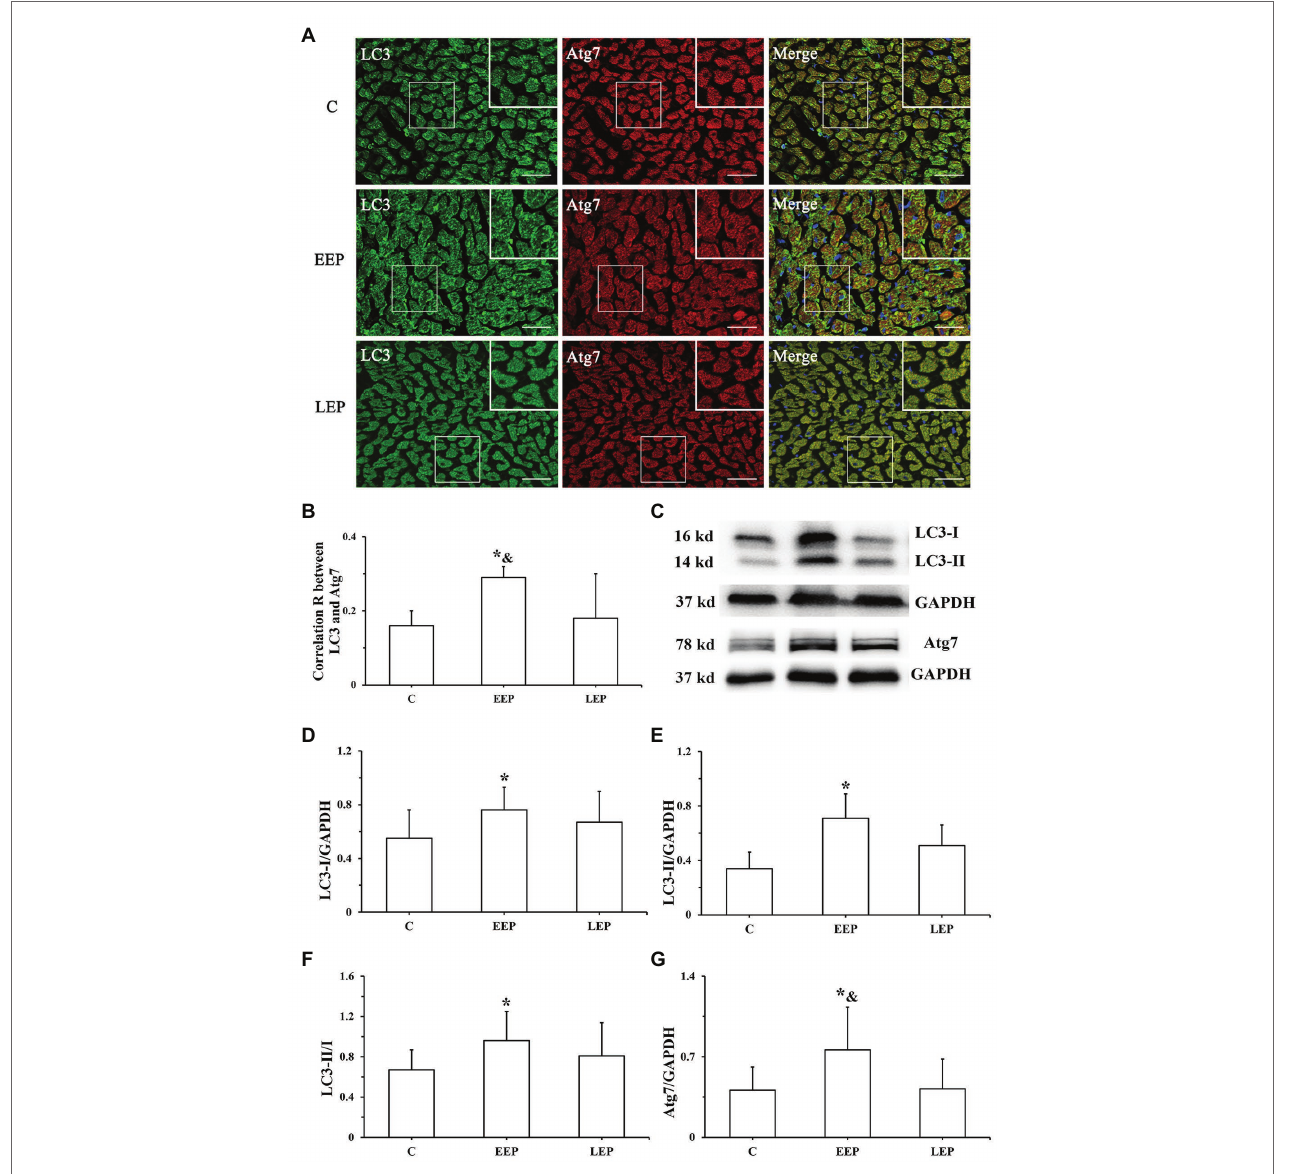
FIGURE 4 | Expression of LC3 and Atg7 levels during EP. (A) Immunofluorescent staining of LC3 and Atg7 in cardiomyocytes (bar = 100 μ m). LC3 immunofluorescence showed green puncta distributed in the cytoplasm. The immunofluorescence images of Atg7 had red puncta distributed in the cytoplasm, and the merged images yielded yellow puncta. (B) Colocalization of LC3 with Atg7 shown as a correlation R. (C) Western blot of LC3 and Atg7. (D) Western blot analysis of LC3-I in different groups. (E) Western blot analysis of LC3-II in different groups. (F) Western blot analysis of LC3-II/LC3-I in different groups. (G) Western blot analysis of Atg7 in different groups. * p < 0.05 vs. group C; & p < 0.05 vs. group